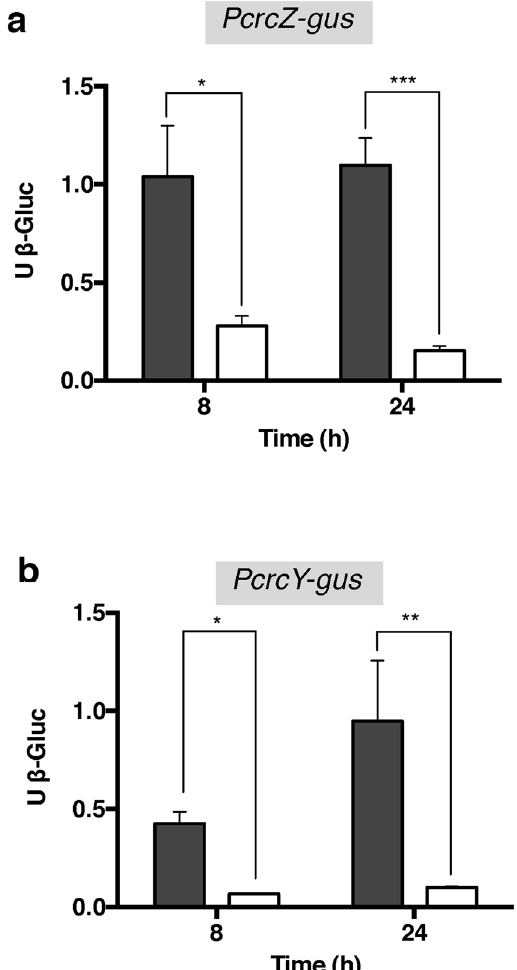
Figure 3. Effect of the HK CbrA on crcZ and crcY gene expression. Expression of crcZ and crcY genes was assessed by PcrcZ - gusA ( a ) and PcrcY - gusA ( b ) transcriptional fusions, respectively. These transcriptional fusions were tested in wild type and cbrA genetic backgrounds. The strains used were: AE-Zgus (wild type; black bars) and CbrA-Zgus ( cbrA ::Sp; white bars) ( a ); AE-Ygus (wild type; black bars) and CbrA-Ygus ( cbrA ::Sp; white bars) ( b ). Cultures were developed in minimal Burk’s-sucrose medium. Aliquots were taken at the indicated times and ß-glucuronidase activity was measured. The bars of standard deviation from three independent experiments are shown. Significant differences were analysed by t -test. Statistical significance is indicated ( * p < 0.05, ** p < 0.01 or *** p <